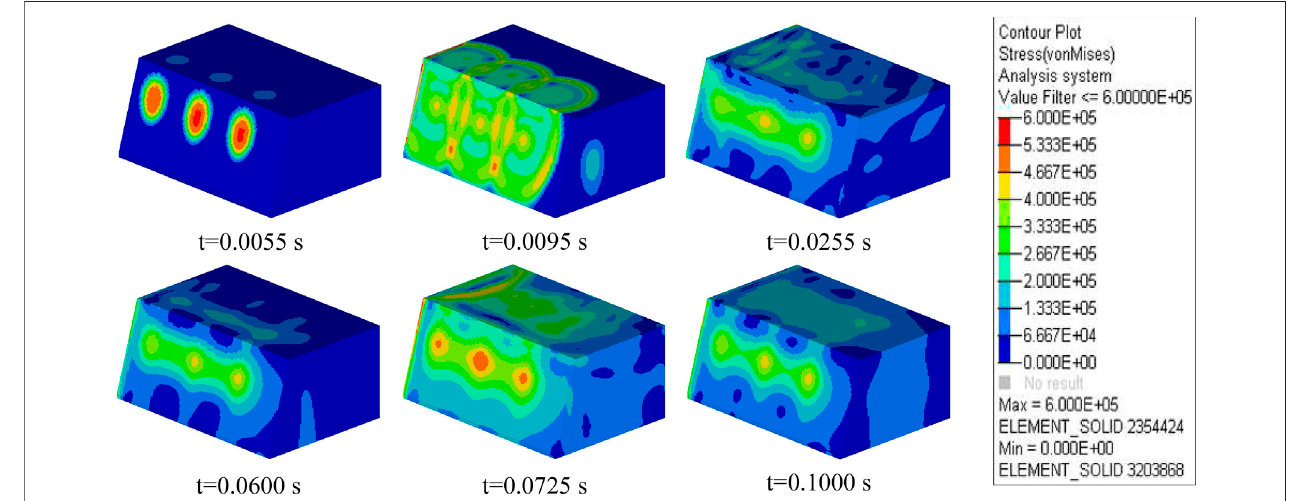
FIGURE 11 | Stress diagram.